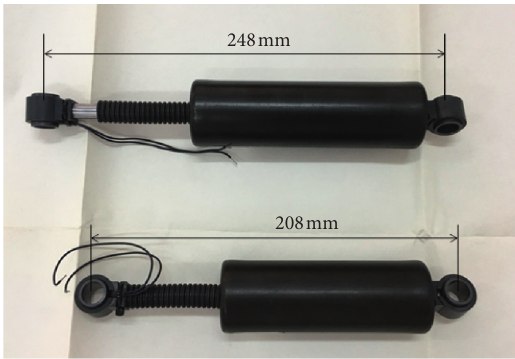
Figure 1: Picture of the MR